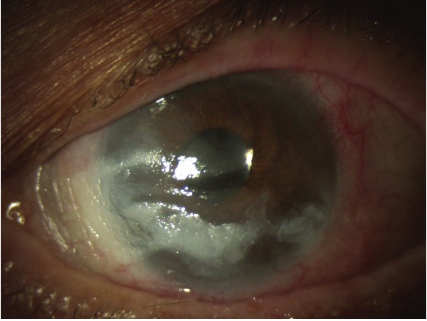
Figure 6: Left eye after therapy.